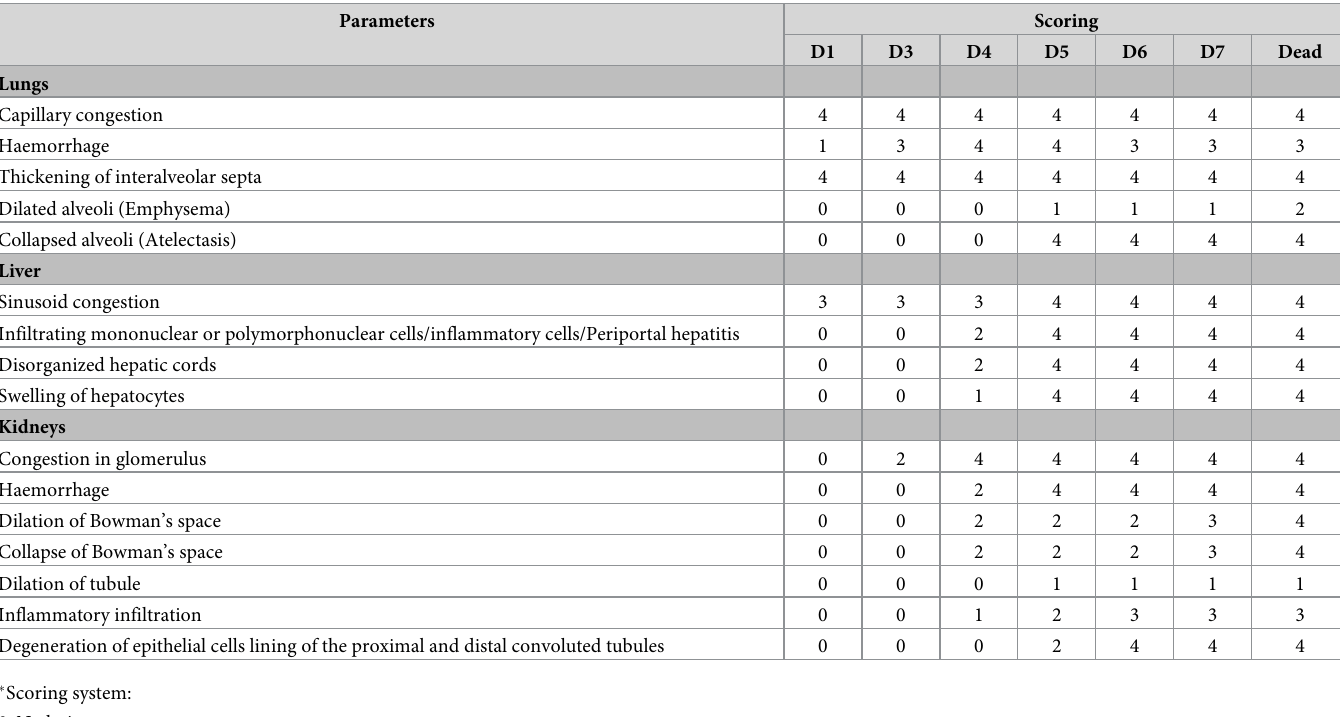
earlier before day 7 p.i. showed similar pathological changes which were haemorrhagic lungs and kidneys and congested liver. No lesions or any pathological changes were observed in the organs of control hamsters.